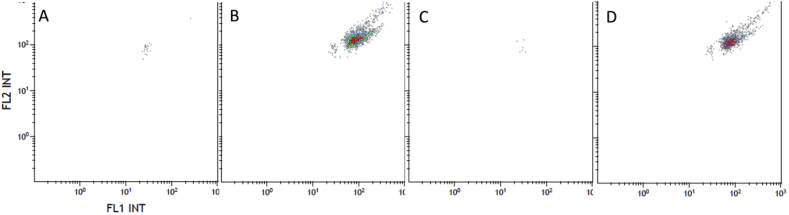
Fluorescent signal artifact of SYBR® Green I-stained T4 bacteriophage sample (∼106 PFU mL−1), obtained by GALLIOS™ flow cytometer. Measurements were performed in the same tube: sample gently transferred into FCM tube after staining (A), immediately after vigorous hand-shaking (B), 20 min after hand-shaking (C), after shaking second time (D). (For interpretation of the references to colour in this figure legend, the reader is referred to the Web version of this article.)